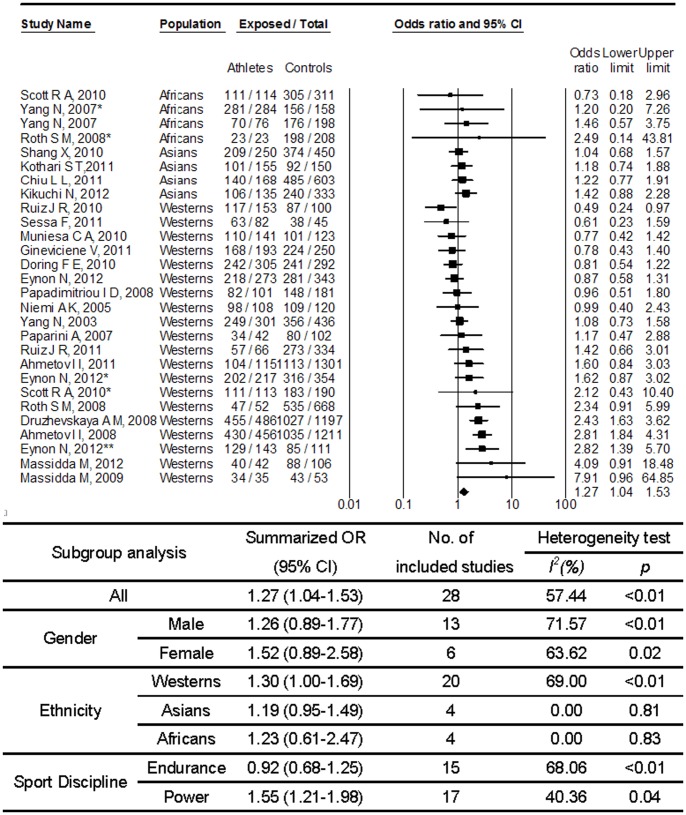
Meta-analysis of the association between sport performance and ACTN3 polymorphism (RR+RX vs. XX).Abbreviation: CI, confidence interval; OR, odds ratio. *Different study population from the same article.